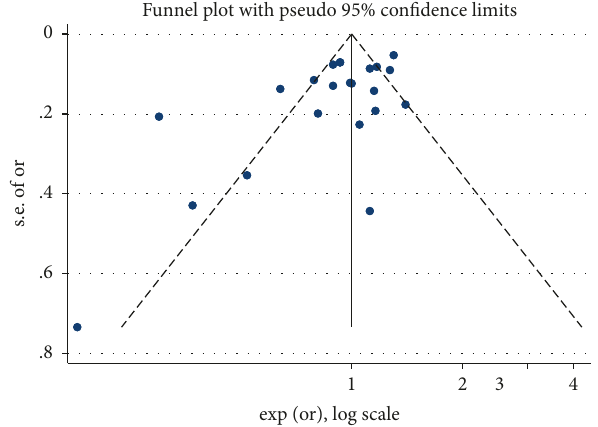
Figure 4: The funnel plot of the relationship between statin consumption and risk of